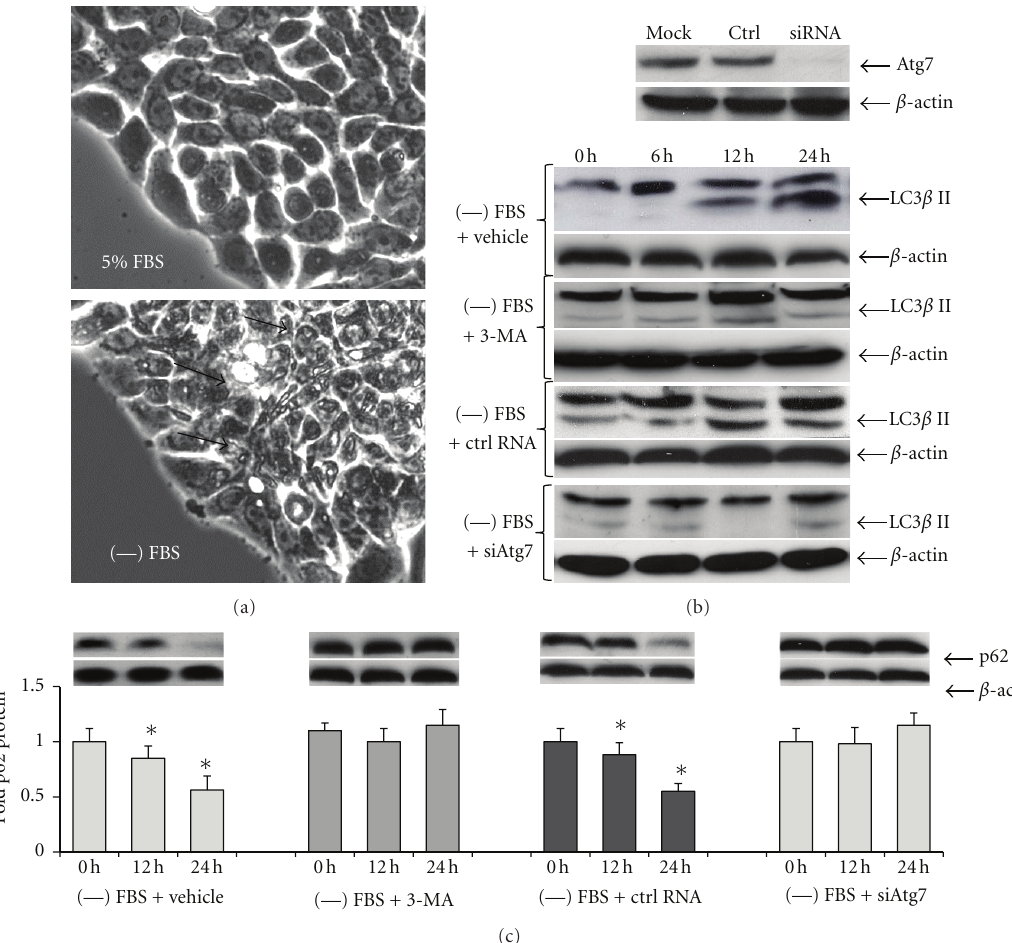
Figure 2: Autophagy is increased in HT-29 cells by serum deprivation and inhibited by 3-methyladenine (3-MA) and Atg7 siRNA. (a) Cells contain basal levels of cytosolic vacuoles in serum-containing media. Cytosolic vacuoles (indicated with arrows) dramatically increased at 24 hours of incubation in serum-free media. (b) Western blots showing silencing of Atg7 by siRNA, but not control RNA (ctrl) relative to mock transfection, conversion of LC3 β I into LC3 β II in vehicle and control RNA-treated cells over time, and inhibition of LC3 β II conversion in 3- MA (10 mM) and Atg7 siRNA (10ng) treated cells over time in serum-free media. Beta-actin blots show equal protein loading in all samples. (c) Graph of protein quantitations from western blots showing degradation of p62 in vehicle and control RNA treated cells over time, and inhibition of p62 degradation in 3-MA (10mM) and Atg7 siRNA (10ng) treated cells over time in serum-free media. One representative western blot out of 3 utilized for the p62 quantitation is shown. ∗ Indicates significantly lower p62 levels relative to 0 hours, P < 0 .